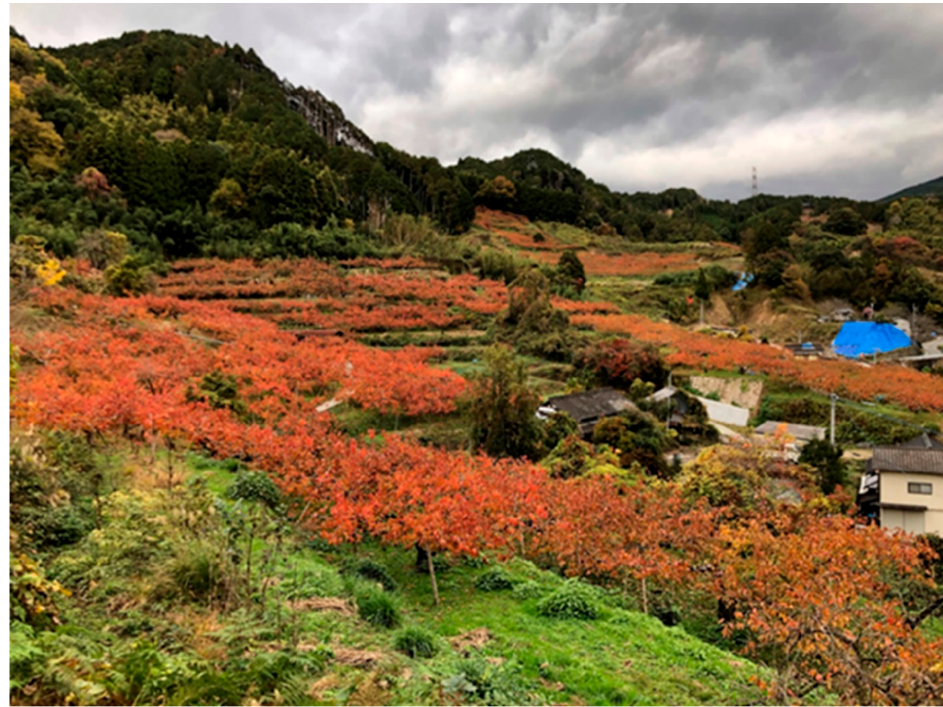
Figure 1. Local landscape formed by persimmon orchards in the Hiraenoki Community (obtained by Yoshio Harada [the first author] on 28 November 2019).